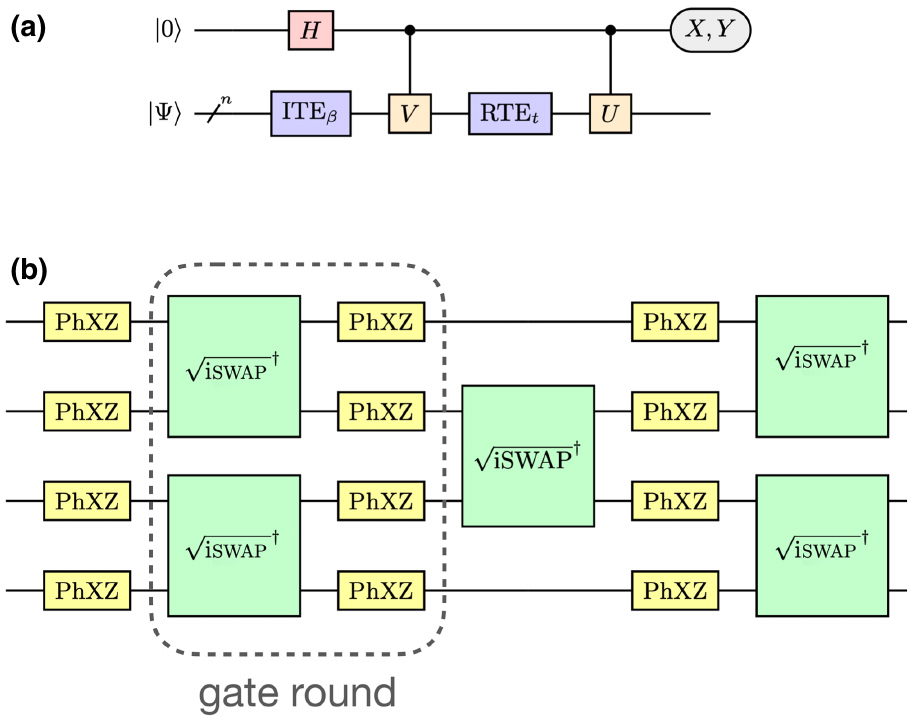
FIG. 2. (a) The quantum circuit to calculate a finite-temperature dynamic correlation function (cid:2) ˆ U ( t ) ˆ V (cid:3) β using QITE and one ancilla qubit. Measuring X and Y on the ancilla yields the real and imaginary parts of the correlation function, respectively. The ther- mal average over the initial states is obtained according to Eq.